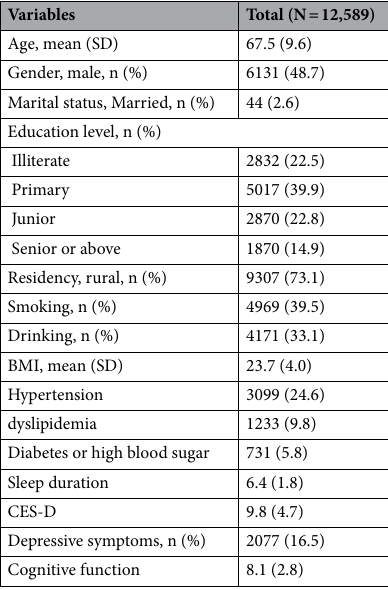
Table 1. Demographic characteristic of participants. BMI body mass index, SD standard